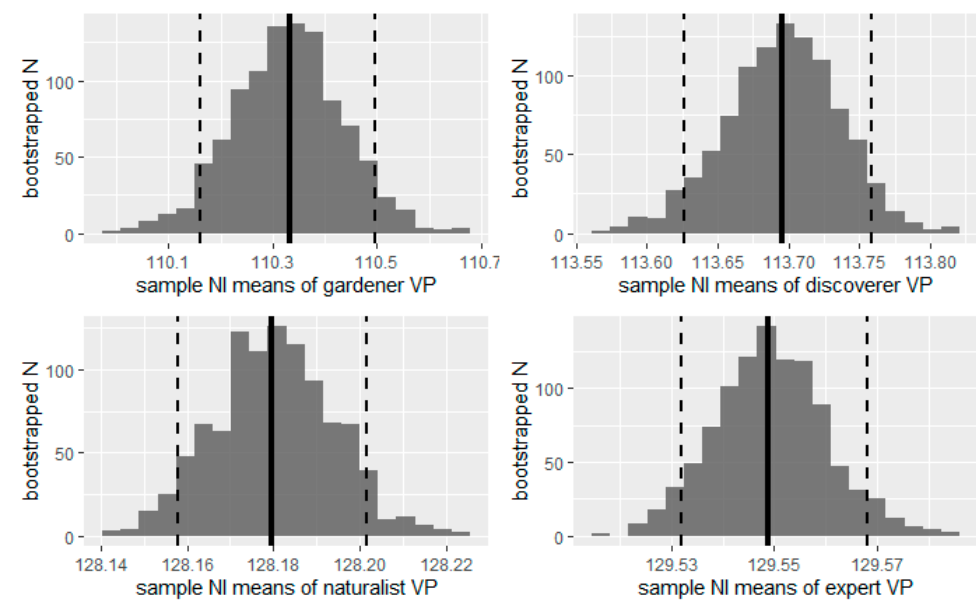
Figure A4. Distribution of NI means with confidence interval boundaries ( p = 0.05) from the 999 bootstrapping resampling for the four observer profiles.